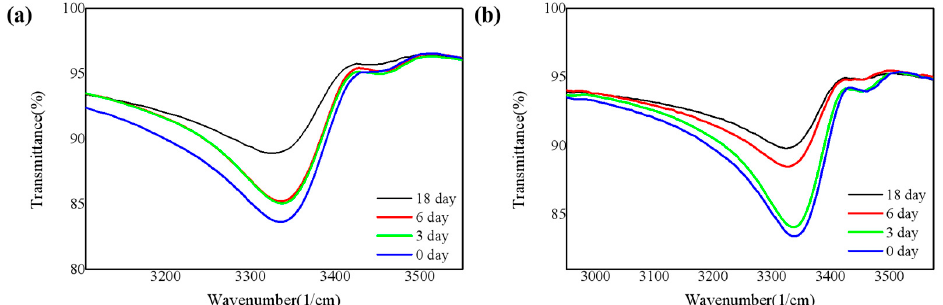
Figure 5. Infrared absorbance in the N-H bond for four SiN x films ( a ) in the air and ( b ) under 85 °C/85% RH. The biggest problem with the microstructure defects of the inorganic thin-film en- capsulation layer is the high porosity at a low temperature. Due to the porous structure of the high-porosity films, water vapor can penetrate the nano-scale channels [24–27]. The surface and the cross-section of the film were observed through SEM. As shown in Figure S3a (Supplementary Materials), the surface of the film is flat, and the SiN x film and the Si substrate have a very clear dividing line. Figure S3b shows that the cross-sectional image of the SiN x thin film of each thickness measured by SEM, showing thin-film structures without columnar structures that could be caused by the diffusion of defects such as grain boundaries. To further study film flatness, the AFM analysis was performed to identify the sur- face topographies of the films after oxidation in the air environment and aging environ- ment (Figures S4 and S5, Supplementary Materials). As shown in Figure S4, the surface of the SiN x film is relatively flat, but there would be island-like deposits of about 3 nm [19,27]. Z. Chongyou pointed out that the island-like and cluster-like morphologies formed on the surface of the film would damage the surface flatness of the film [28]. Therefore, the root mean square (RMS) roughness over a scanned area of 2 × 2 nm of different barrier struc- tures before and after oxidation was deduced. The results show that the roughness of the SiN x films was basically maintained at about 1.3 nm. The flatness was high, and the surface morphology did not change significantly over time. Similarly, almost no change in the surface morphology of SiN x films placed under 85 °C/85% RH was found as shown in Figure S5. It demonstrates that the surface morphology and flatness of the low-tempera- ture SiN x film did not change significantly due to oxidation. Transmittance is a key factor as TFE film of flexible display, and the corresponding result is shown in Figure 6. Due to the interference effect of the upper and lower surfaces of the SiN x films to the light, the transmittance changes in a sinusoidal fluctuation trend [1]. As shown in Figure 6a, as the oxidation time increases, the transmission performance of the SiN x film hardly changes. Only in the 400–600 waveband, the transmittance of the film has a slight upward trend. Three samples were selected for comparison in the 500– 600 waveband as shown in Figure 6b to better observe the changes in the permeability of the SiN x film in the reference wavelength range. Inset graph of Figure 6b visually demon- strate the good transmittance of the SiN x film deposited on glass. It is believed that when the ratio of nitrogen to oxygen decreases, the extinction coefficient gradually decreases, and the ability of the film to absorb light decreases, which leads to an increase in the trans- mittance of the film [29].